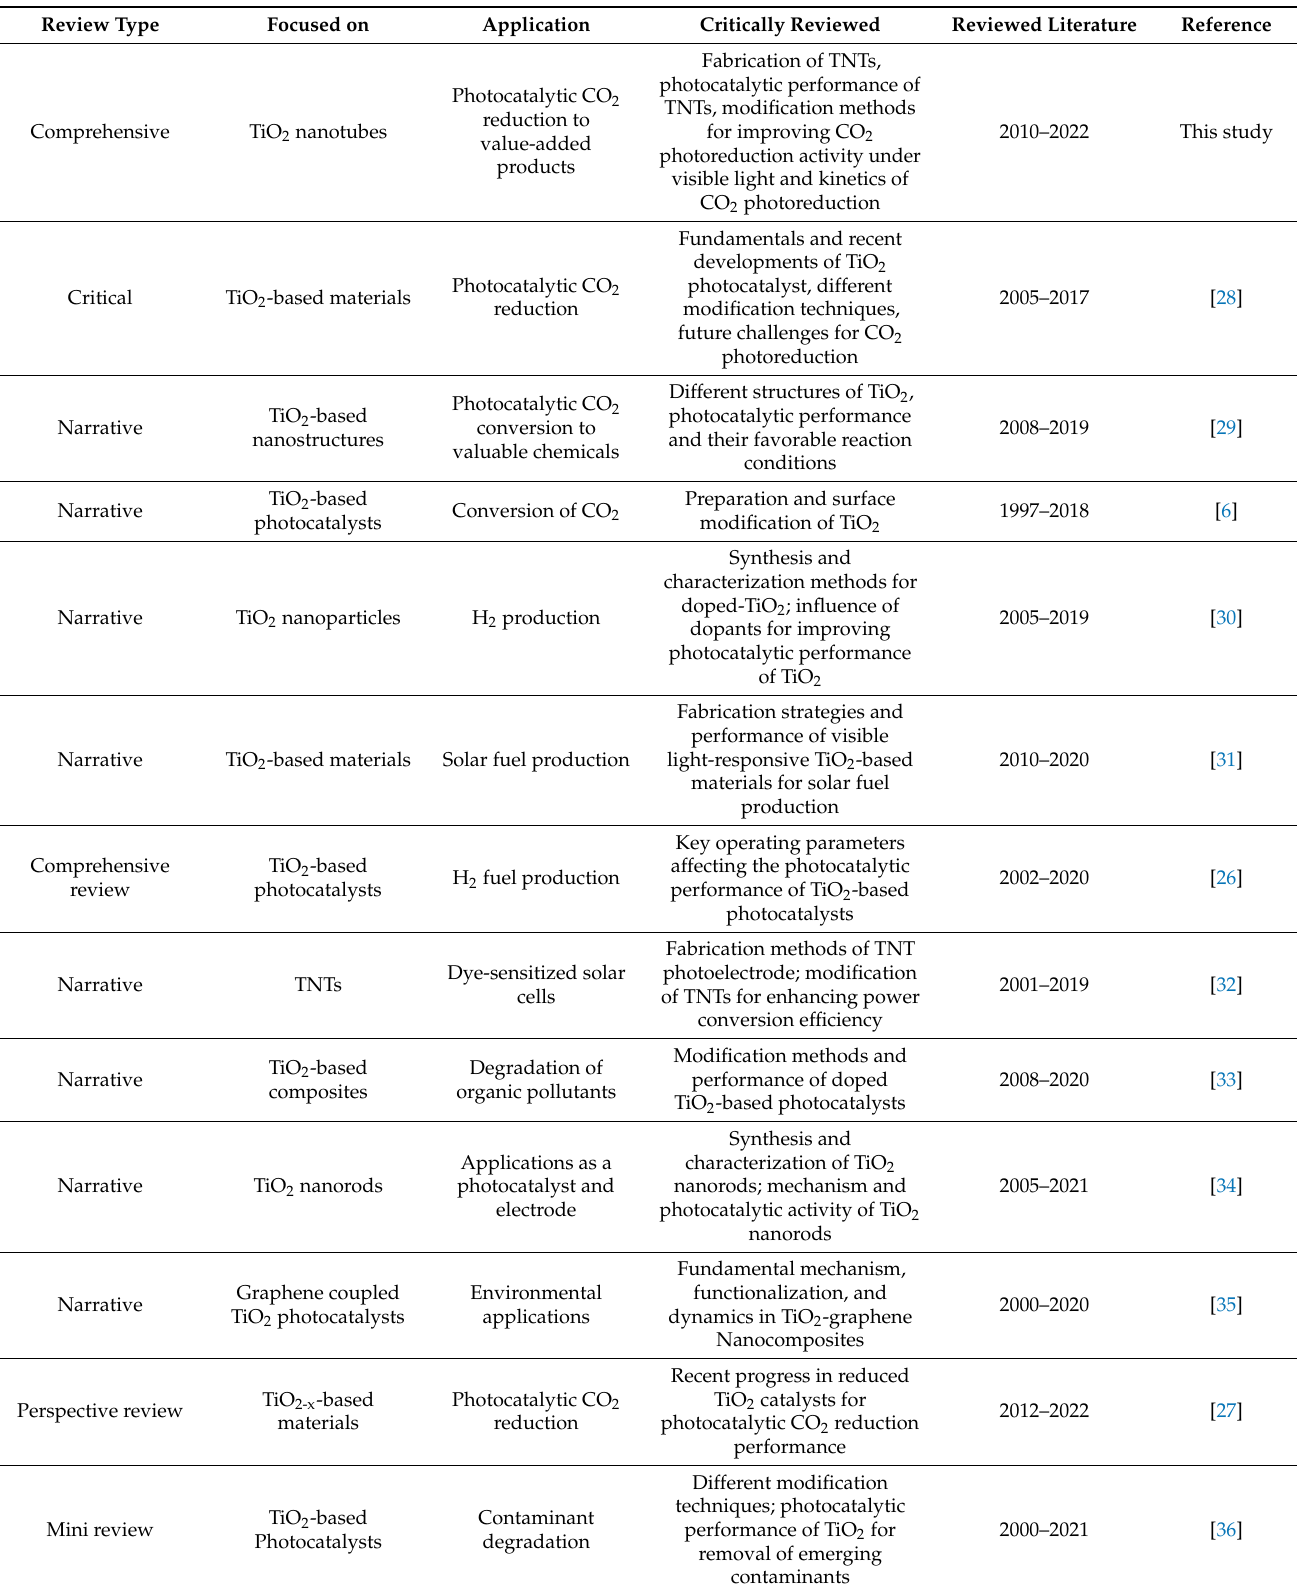
Table 1. Comparative summary of reviewed articles on different structures and composites of TiO 2 for variety of